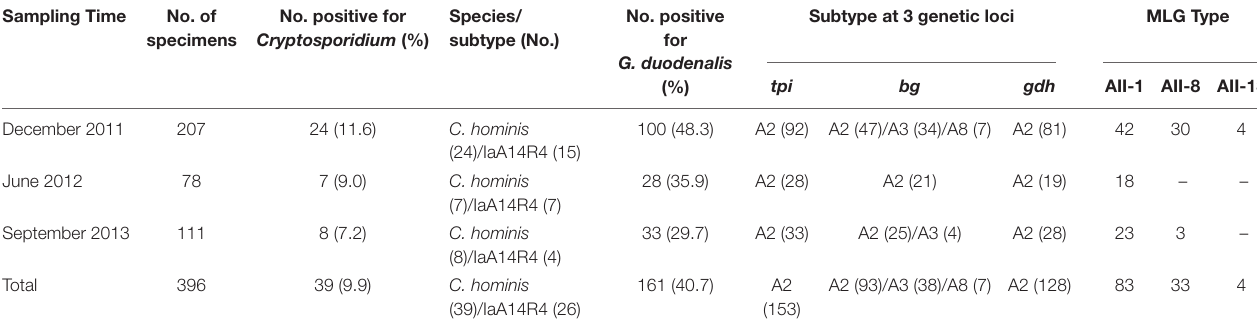
TABLE 1 | Occurrence of Cryptosporidium hominis and Giardia duodenalis among 396 specimens from children in a welfare institute in Shanghai, China. Sampling Time No. of